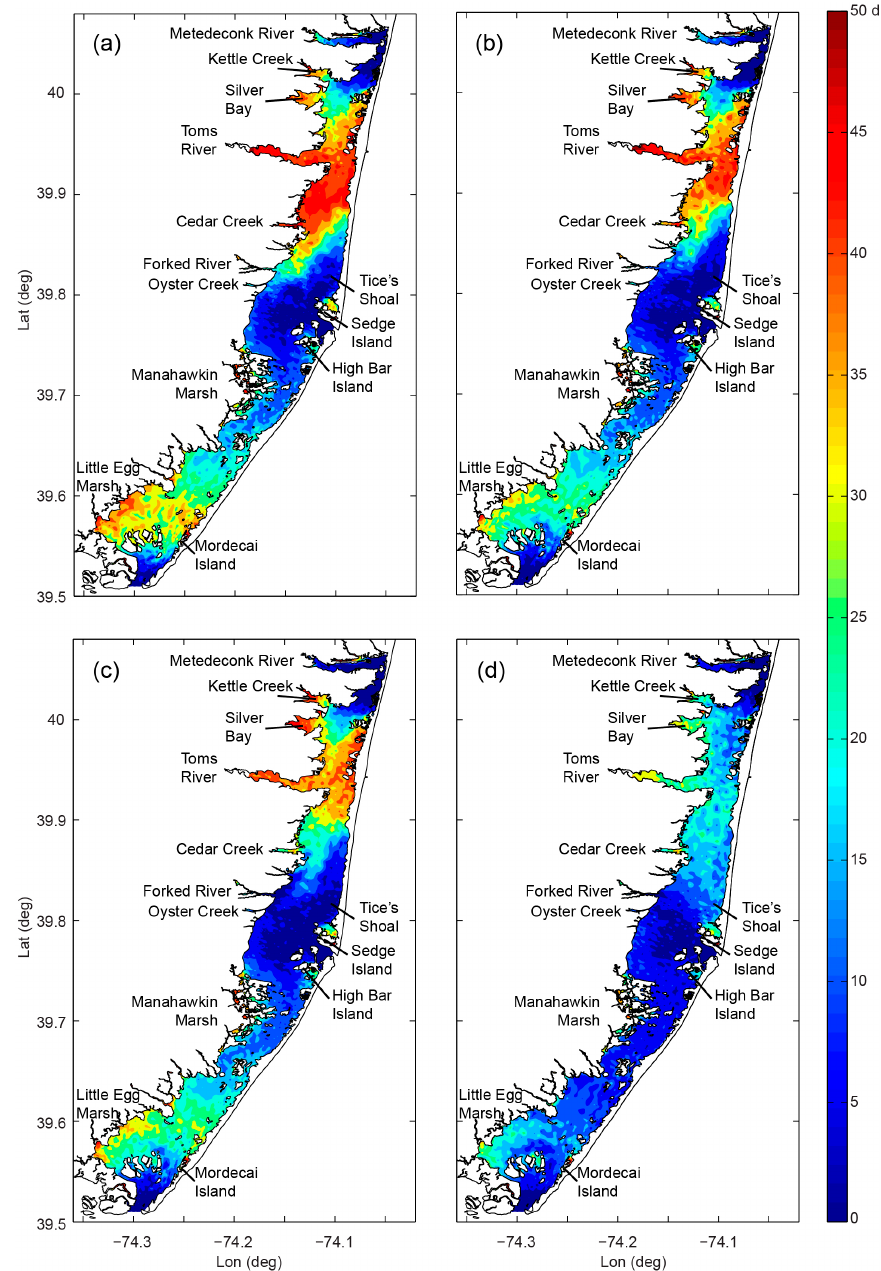
Figure 10. Spatially variable residence times computed by Defne and Ganju [101] with coupled 3D hydrodynamic and particle tracking models applied to Barnegat Bay-Little Egg Harbor (New Jersey, USA). The scenarios shown are ( a ) tidal forcing only, ( b ) tidal plus remote coastal forcing, ( c ) like ( b ) but with river flow added, ( d ) like ( c ) but with meteorological forcing added. Two inlets—Little Egg Inlet at the southern end and Barnegat Inlet near the center—connect the ocean and estuary (see Figure 1 in [101] for detailed site map). (Modified from Defne and Ganju [101]). Forward-running models implementing conservative numerical tracers (an Eulerian approach) are also commonly used for assessing timescales. For example, flushing (or renewal) time can be obtained by tracking total tracer mass in a defined region and identifying the time needed for mass to decay to a prescribed level (e.g., 1/ e [114,121] or some other fraction [178] of initial mass).